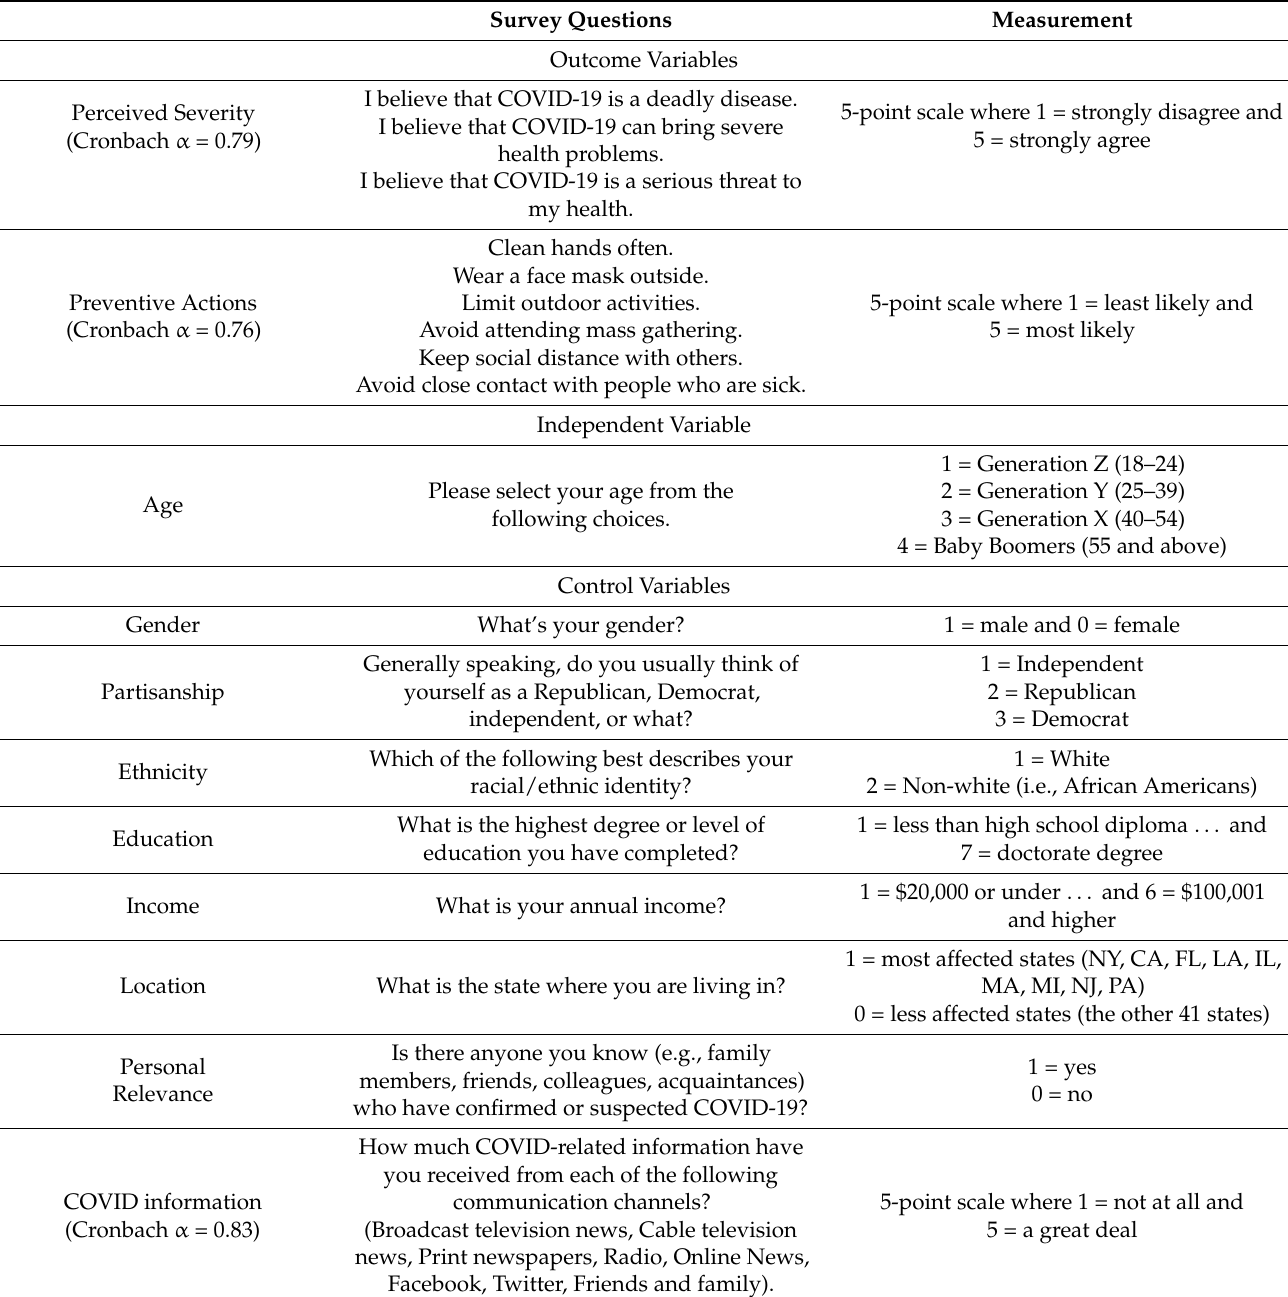
Table 2. Summary of variables, survey questions, and